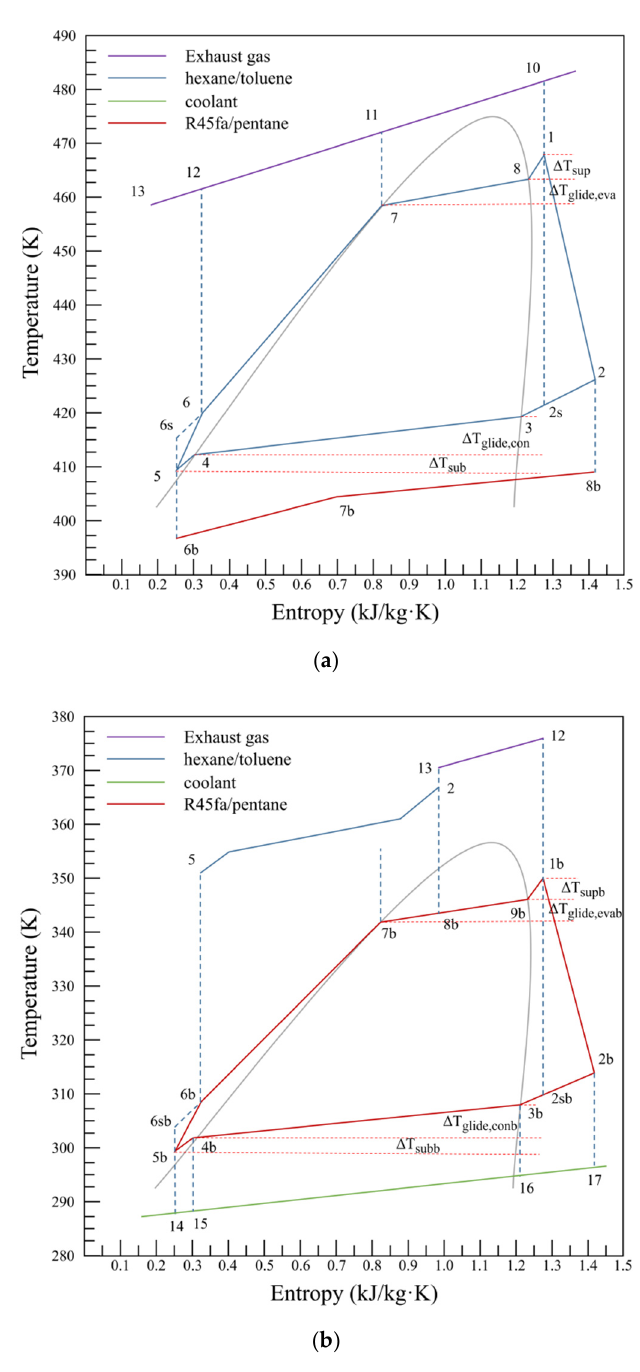
Figure 2. T-s diagram for the system: ( a ) The high-temperature loop; ( b ) the low-temperature loop. Similar to HT loop, the low-temperature fluid from condenser (H4) is first pumped. Then the working fluid flows into heat exchangers (H2, H3) sequentially and absorbs residual heat of heat source and HT loop fluid, respectively. The saturated or superheated fluid enters the expander (T2) and expands to produce energy, and the pressure decreases to a prescribed condensation pressure. Eventually, the low-temperature loop fluid is cooled in condenser (H4) and flows into the pump for